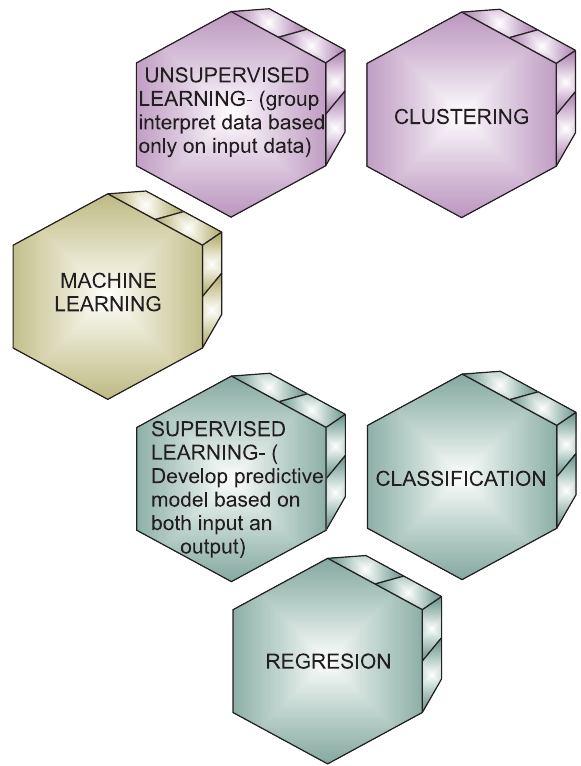
Figure 1. Classification of the machine learning approaches according to the